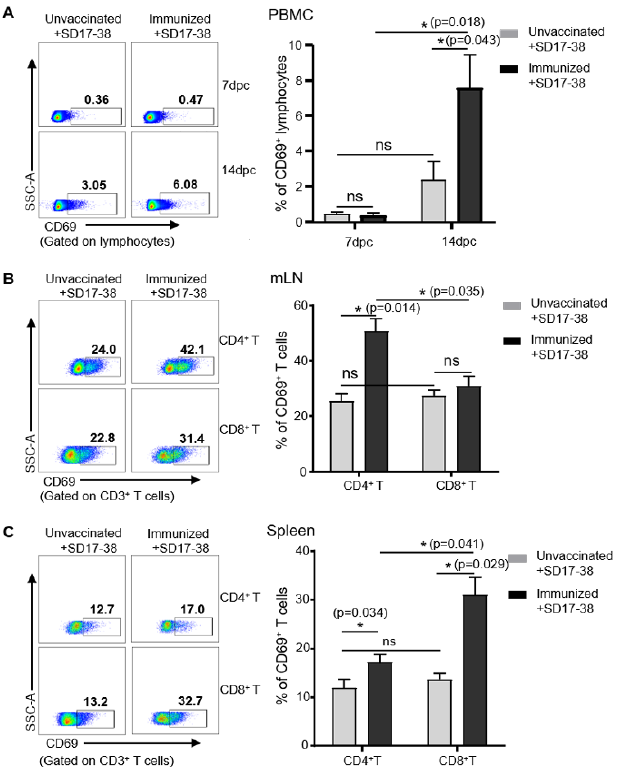
Figure 5. The detection of CD69 expression on T cells in different organs after PRRSV immunization and infection. PRRSV-free piglets were immunized intranasally and intramuscularly with the rJS-ORF2-6-CON vaccine or were administered RPMI-1640 (as the control), then challenged with a virulent PRRSV NADC30-like SD17-38 isolate on day 42 post-immunization. Peripheral blood, mediastinal lymph nodes (mLN), and spleens were harvested on days 7 and/or 14 post-challenge (dpc) and single-cell suspensions were prepared for the detection of CD69 expression on T cell subsets via flow cytometry. ( A ) Representative pseudocolor plots (left panel) and the dynamic changes (right panel) of total CD69 + lymphocytes in the PBMCs of unvaccinated ( n = 3) and immunized pigs ( n = 3) after challenge. ( B , C ) Representative dot-plots (left panel) and the comparison (right panel) of CD69 + CD4 + and CD69 + CD8 + T cells in the mLNs and spleens of unvaccinated ( n = 3) and immunized pigs ( n = 3) at 14 dpc. Data shown are mean ± SEM. ns, no statistical significance. * p < 0.05.